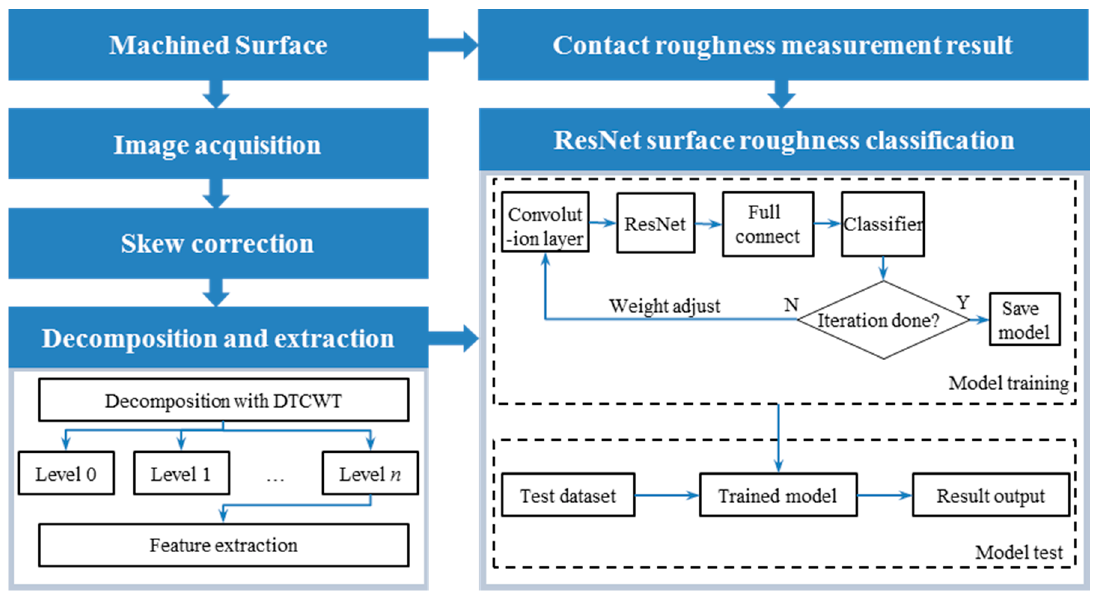
Figure 10. Flow chart of the proposed method.